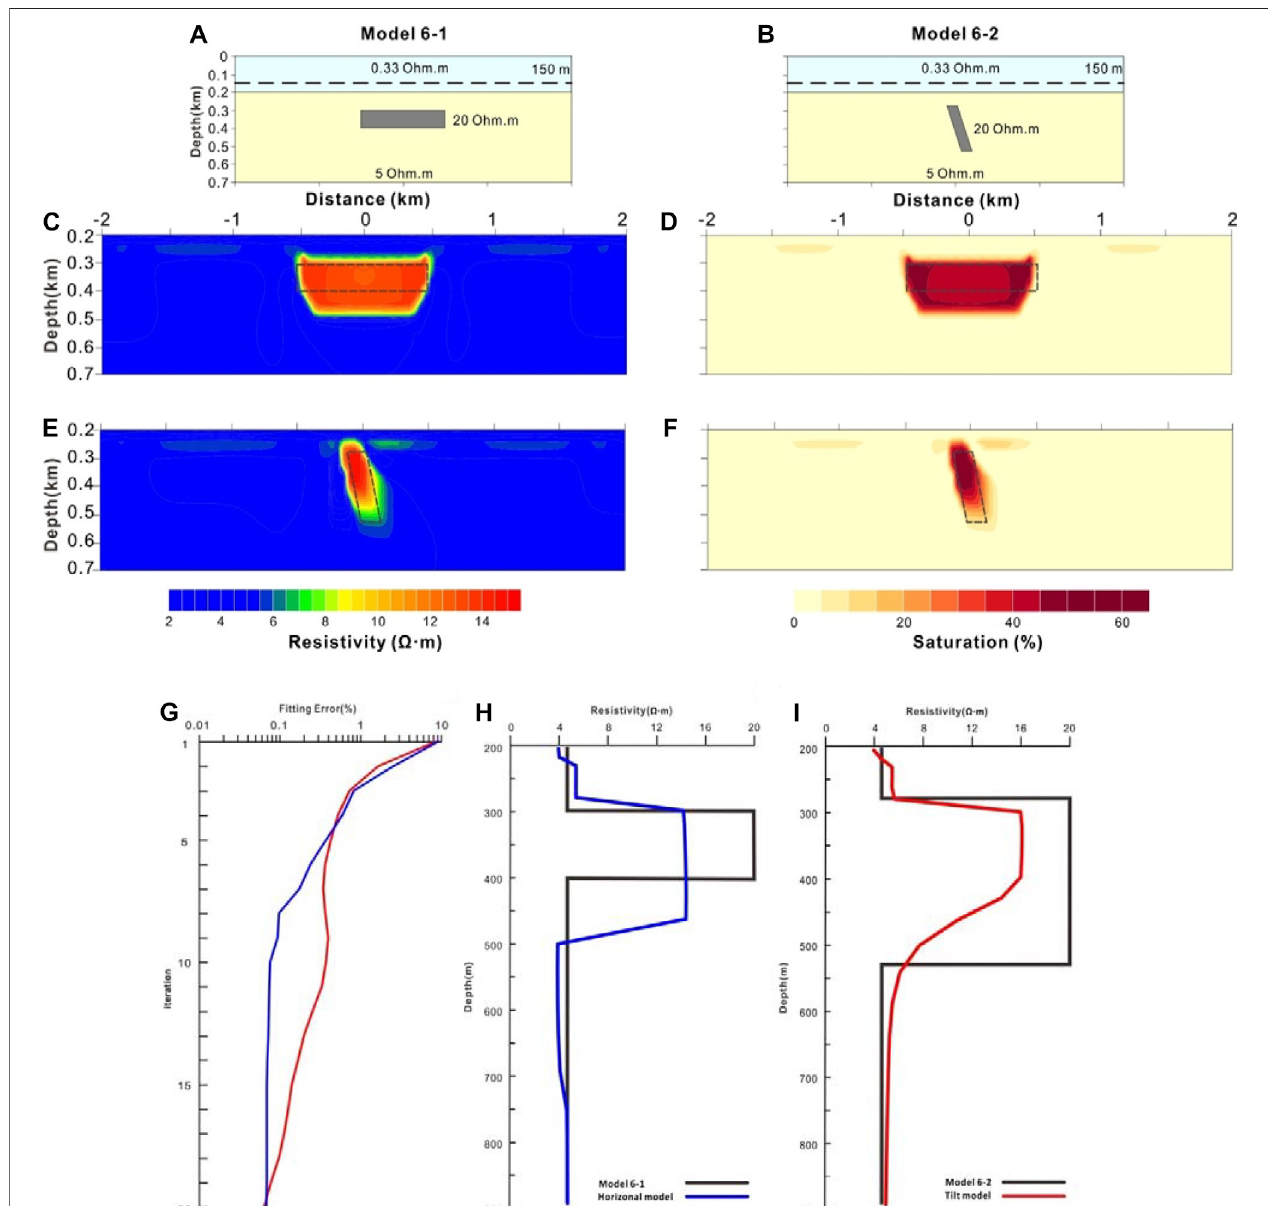
FIGURE 9 | Resistivity inversion and hydrate saturation estimation of the various thickness model of hydrate reservoir. (A) – (B) : the schematic diagram of Model 6- 1and6-2respectively,lightblueindicatesseawater,lightyellowindicatesmarinesediments,grayblockindicateshydratereservoirs,dottedlineindicatesthetrackofthe towed DCR array arrangement; (C) and (I) the inversion resistivity of Model 6-1and 6-2 respectively; (D) and (F) : the hydrate saturation estimation of Model 6-1 and 6- 2respectively; (G) :theinversioniterationconvergenceofModel6 – 1(blue)and6 – 2(red),respectively; (H) – (I) :theresistivitypro fi lewithdepthatthecenterxposition of hydrate reservoir of Model 6 – 1 (blue) and 6 – 2 (red),